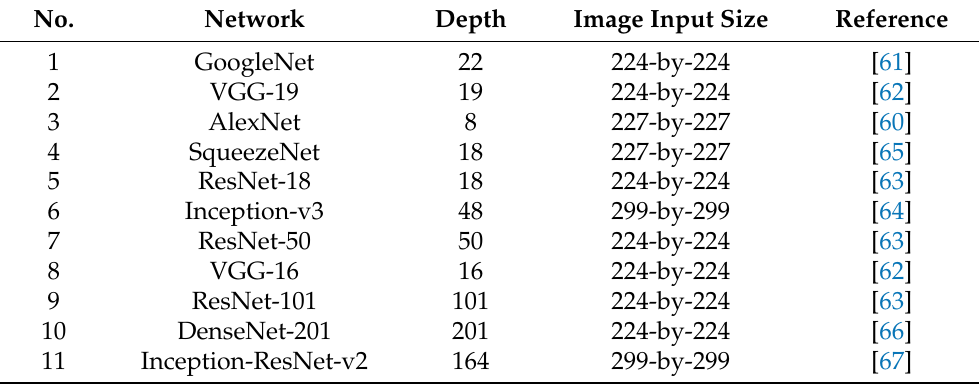
Table 3. Details of convolutional neural networks (CNNs) that were used in this